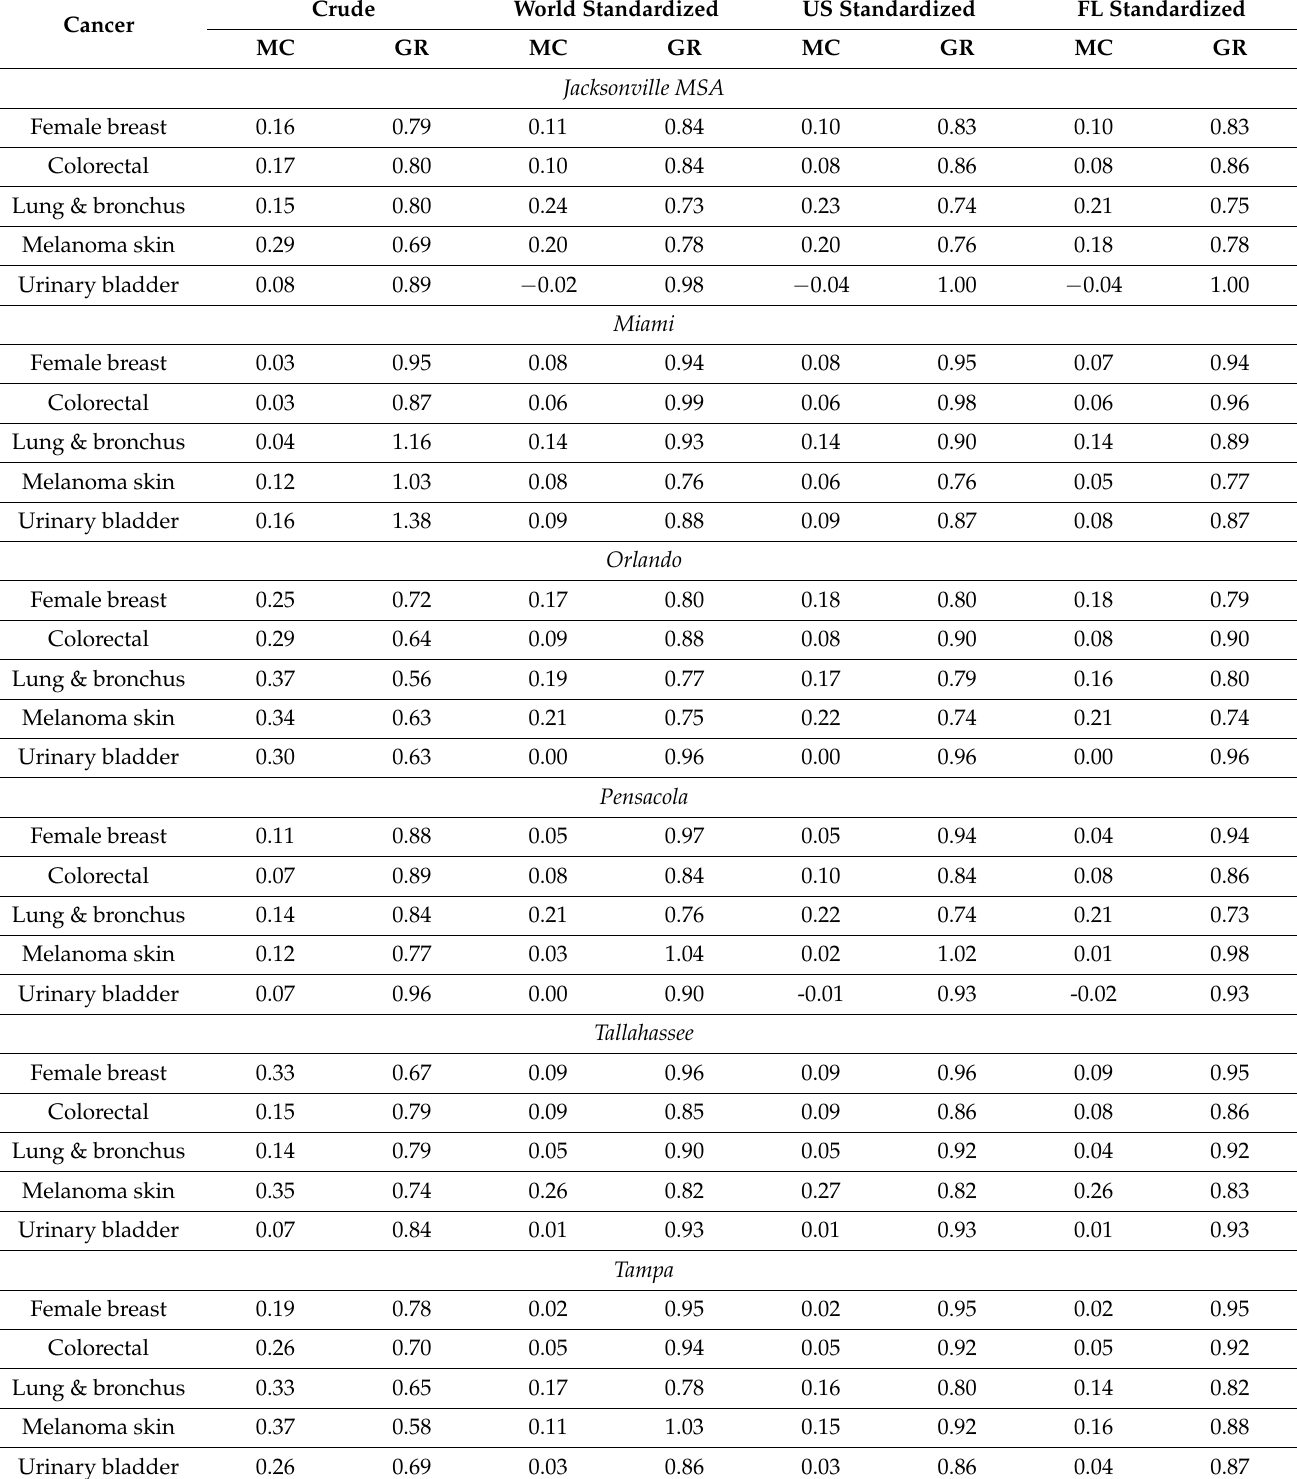
Table 4. Traditional SA indices for the five selected cancer types by MSA and standardization reference